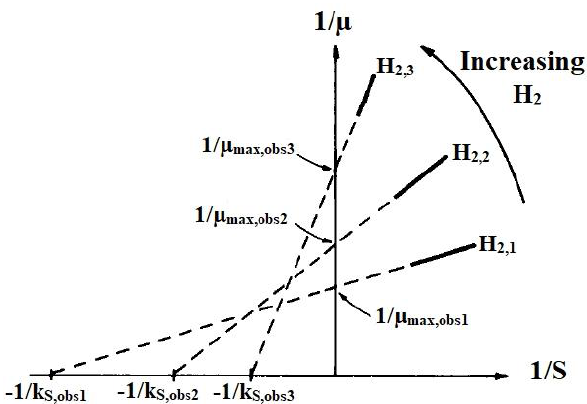
Figure 3. Evaluation procedure of μ max,obs and ks, obs at various concentration of inhibitor; Reproduced with permission from Keehyun Han and Octave Levenspiel, Biotechnology & Bioengineering; published by John Wiley and Sons, 2004 [21]. by John Wiley and Sons, 2004 [21].